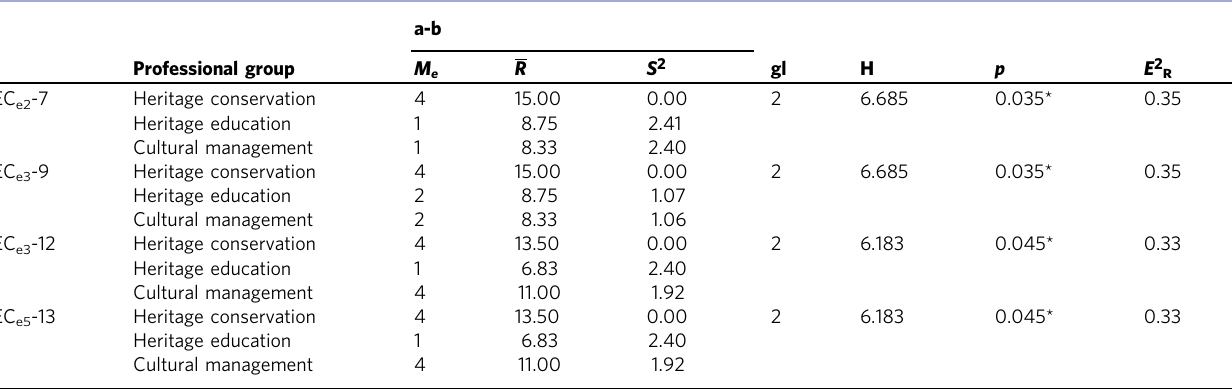
Table 8 Valuative differences as a function of the professional